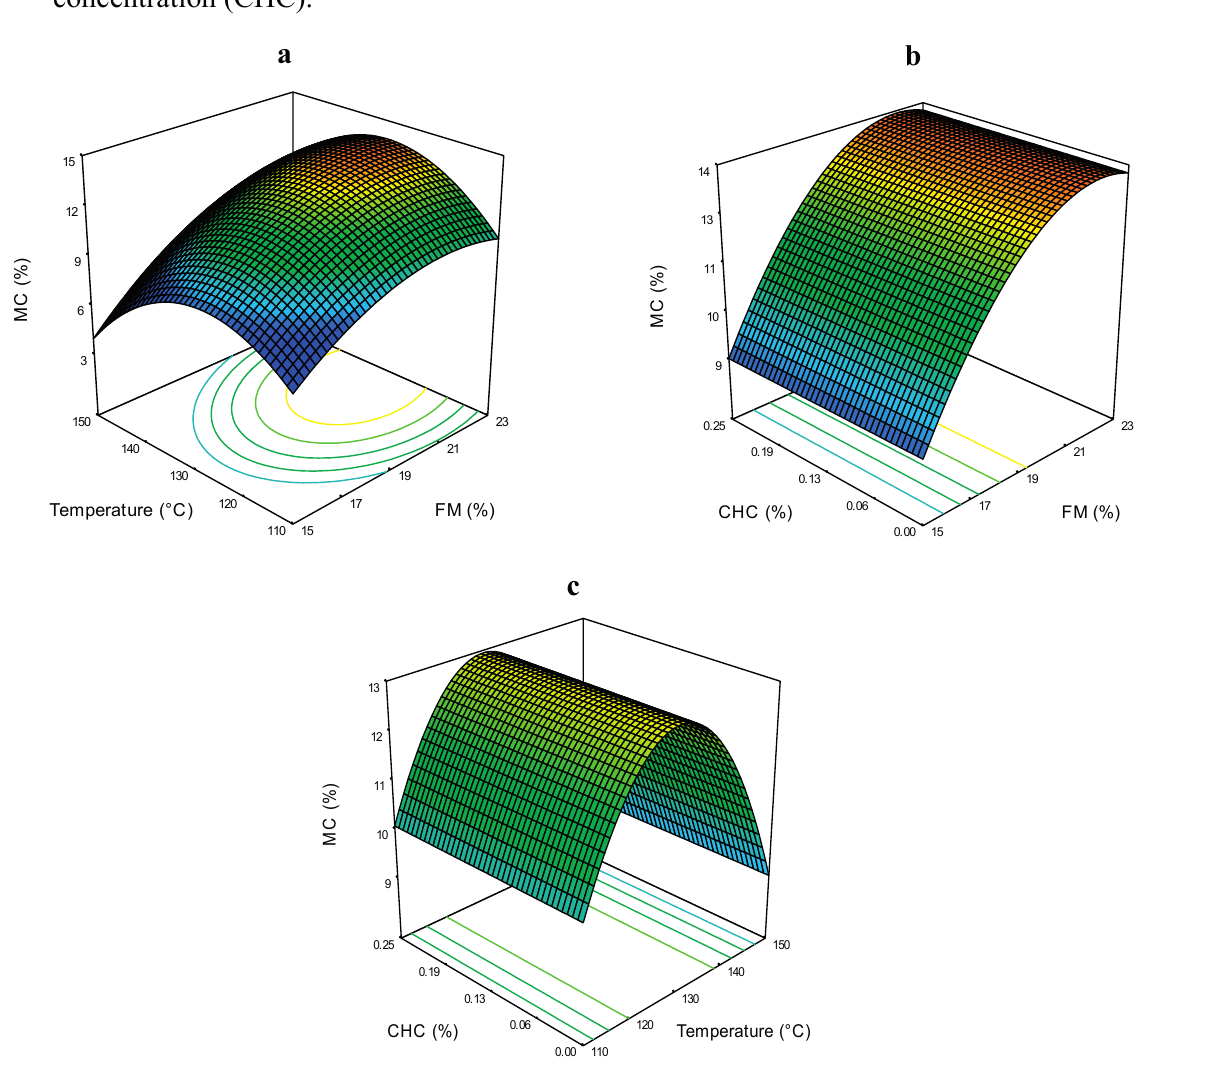
Figure 1. Moisture content (MC) of expanded nixtamalized blue corn extrudates, as a function of: ( a ) feed moisture (FM) and temperature (T); ( b ) feed moisture (FM) and calcium hydroxide concentration (CHC); and ( c ) temperature (T) and calcium hydroxide concentration